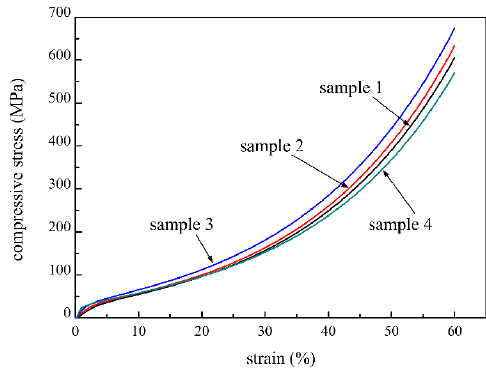
Figure 3. Compressive curves of the compacted sample 1–4 with 4 wt.%, 6 wt.%, 8 wt.% and 0 wt.% fiber content, respectively.